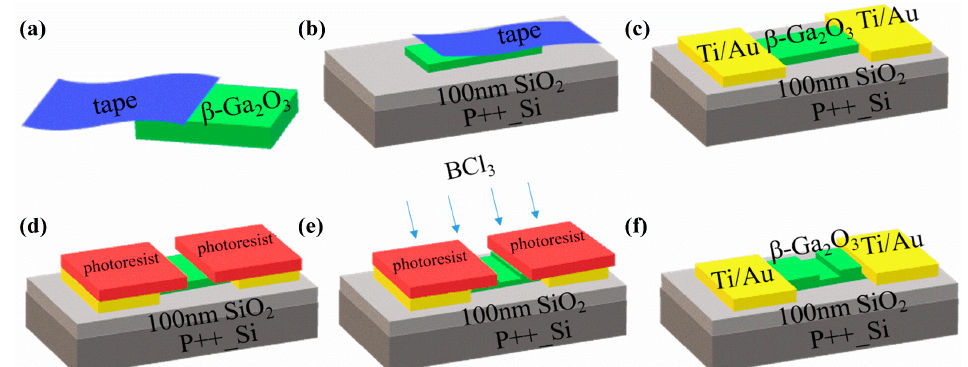
Figure 1. Schematic of the exfoliated β− Ga 2 O 3 − flake − based enhancement − mode FET fabrication pro- cess: ( a ) Nano − scale thickness β− Ga 2 O 3 flakes were prepared by repeated mechanical exfoliation from the bulk Ga 2 O 3 crystals, ( b ) β− Ga 2 O 3 flakes were transferred to a p − type silicon wafer, ( c ) the schematic structure of the fabricated β− Ga 2 O 3 flake FET, ( d ) the etched position of the local thinning after the FET device was subjected to a photolithography process, ( e ) etching to form the local thin- ning and ( f ) the schematic structure of the β− Ga 2 O 3 flake FET with the local thinning.